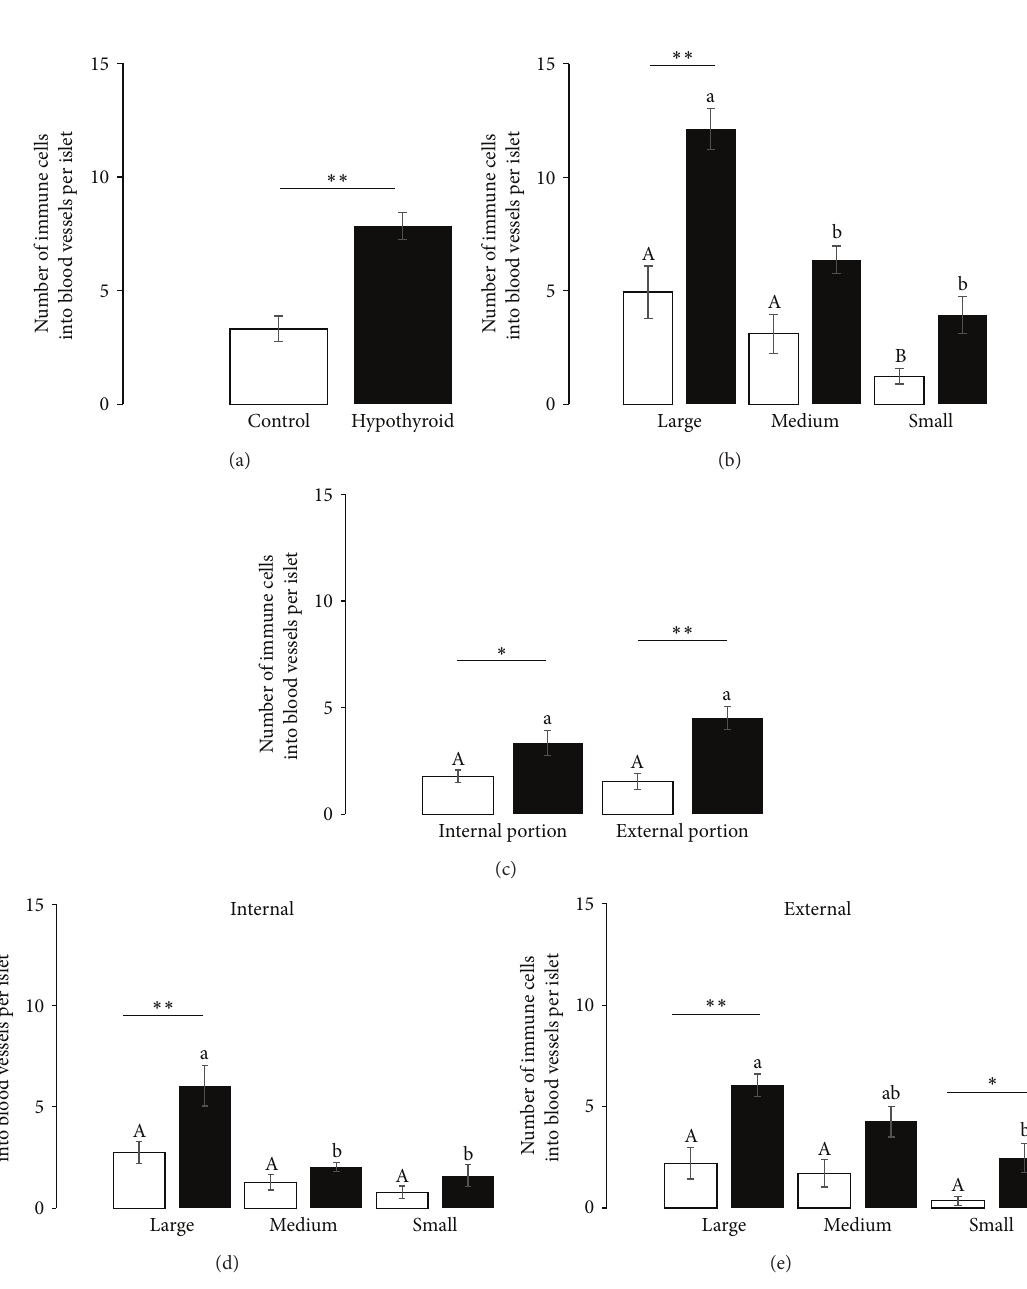
Figure 3: Infiltration of immune cells into islets from control ( light ) and hypothyroid ( dark ) female rabbits. Number of immune cells in overall islets (a), in islets categorized by size (b), in portions of the islets (c), in the internal portion of islets categorized by size (d), and in the external portion of islets categorized by size (e). Different capital letters indicate significant differences between sizes of islets in control females. A similar order is given by lowercase letters for hypothyroid females. Asterisks indicate significant differences between treatments ∗ 𝑃 < 0.05 and ∗∗ 𝑃 < 0.01